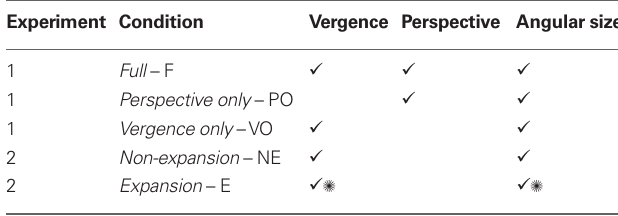
Table 1 | Experimental conditions and available depths